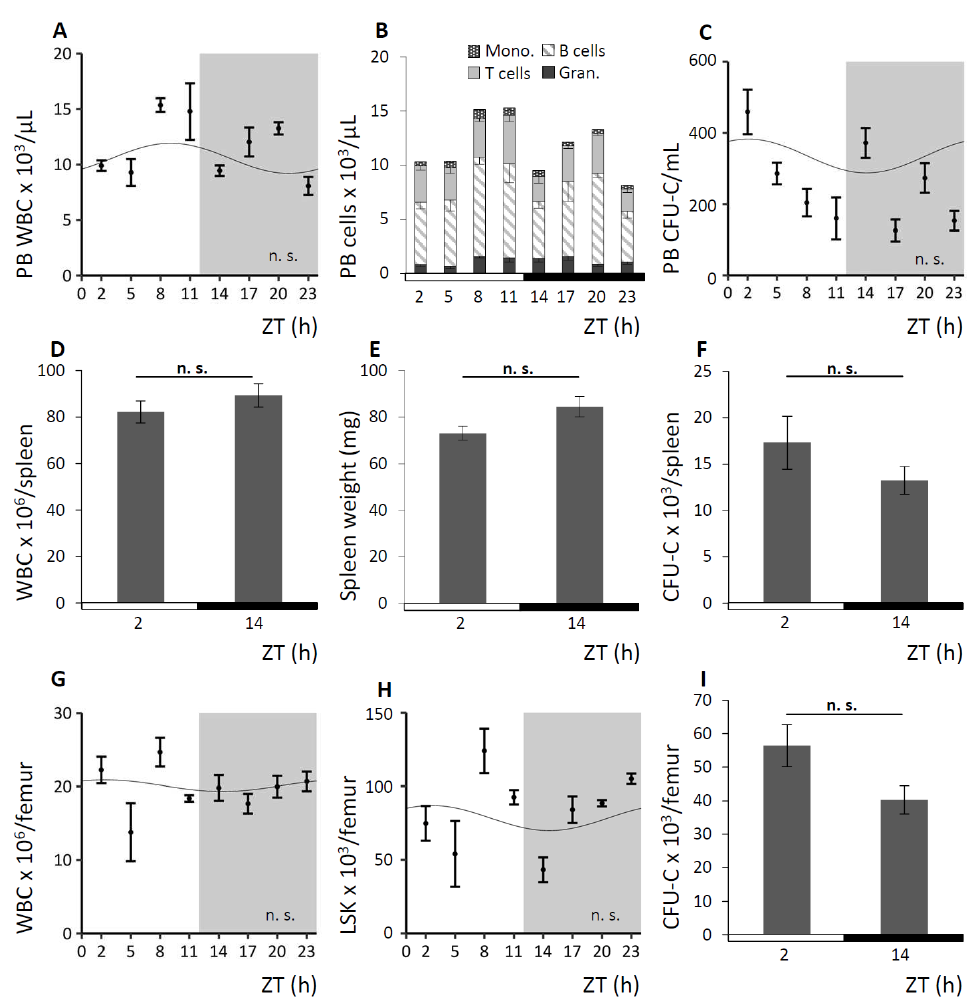
Figure 2. Bmal1 −/− mice lack circadian blood cell oscillation . Bmal1 −/− mice were kept under LD